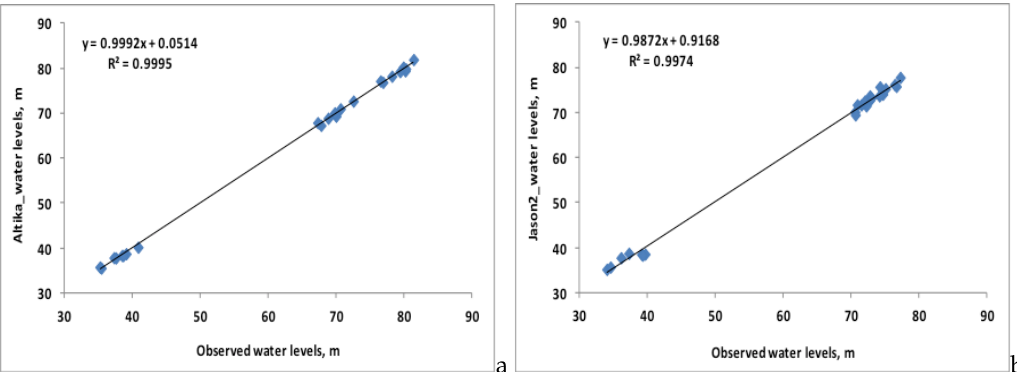
Figure 16. Overall relationship between observed versus retrieved water levels taking into account all study tracks: ( a ) SARAL/AltiKa ; and Jason-2 ( b